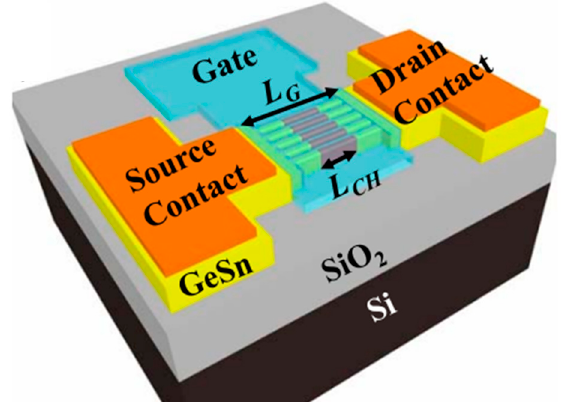
Figure 40. 3D diagram and highlights of the first GeSn FinFETs grown on a GeSnOI substrate. Reproduced with permission from [93], IEEE, 2018.